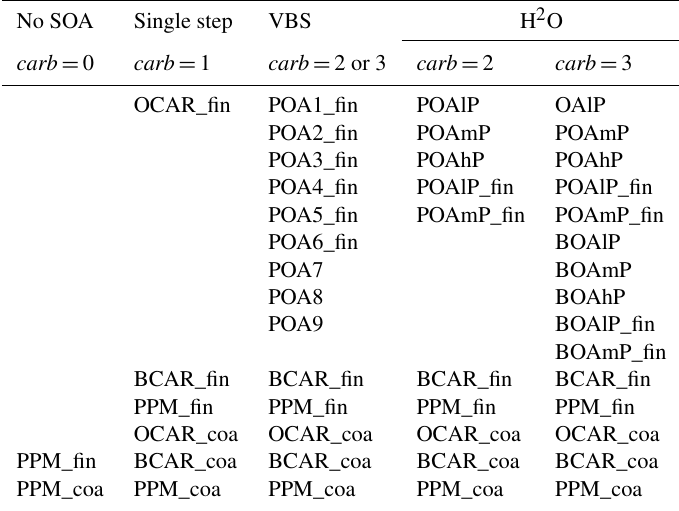
Table 6. List of anthropogenic emitted species depending on the way to split the emissions of primary particulate matter (PPM) and the chemical scheme used for the SOA formation.